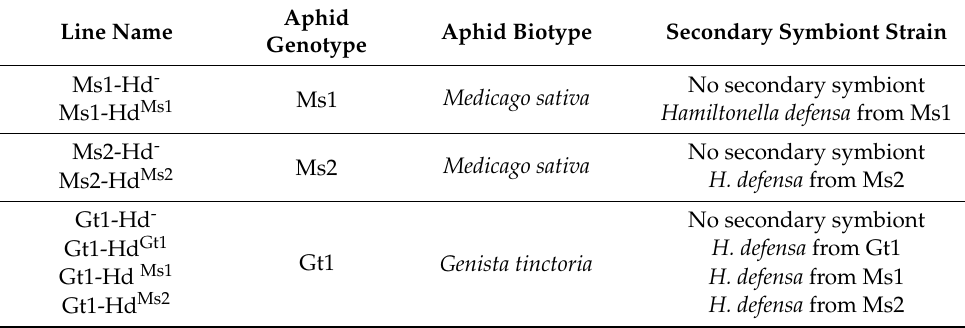
Table 1. Features of the eight lines of Acyrthosiphon pisum in the